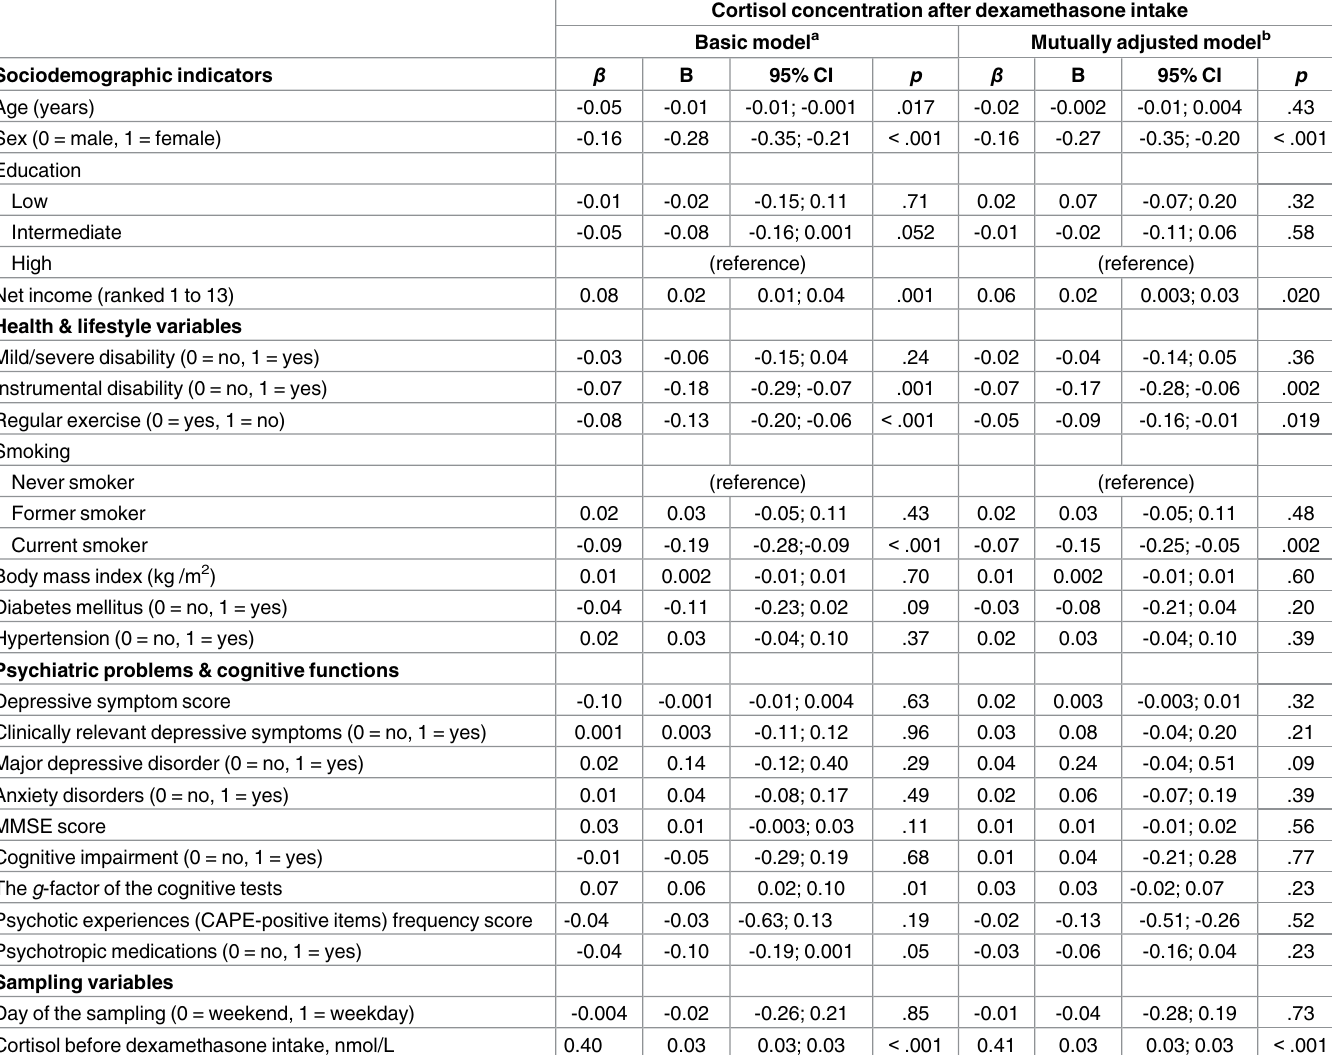
Table 2. Relations of determinants with cortisol concentrations after dexamethasone intake.